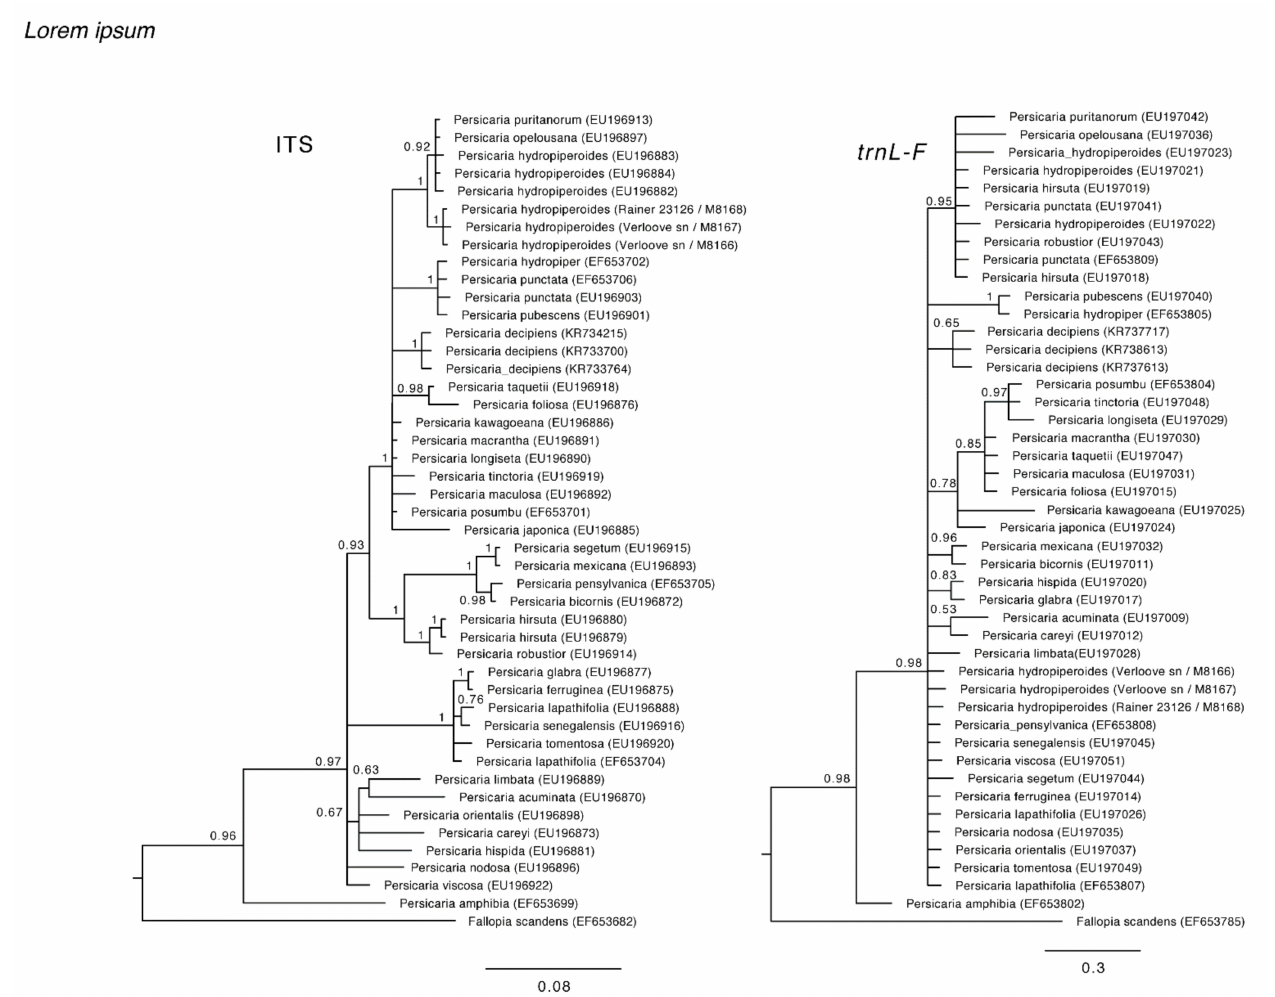
Figure 3. trnL-F and ITS